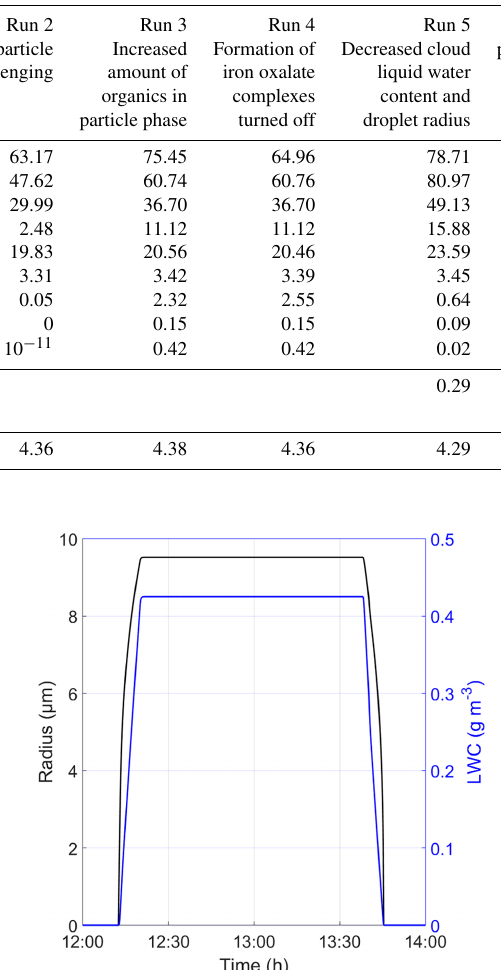
Table 4. Chemical concentrations, pH and cloud liquid water content (LWC) measured in clouds sampled at Puy de Dôme and calculated by the model during the six different runs. Main characteristic settings are recalled for each run. Observations Marine Concentration